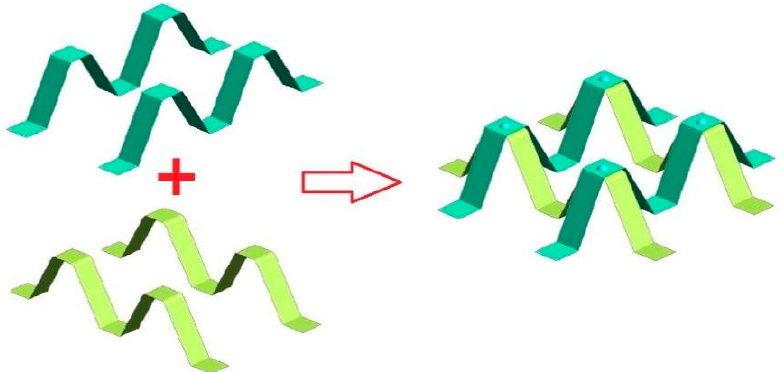
Figure 10. Single layer “M support” welding module.